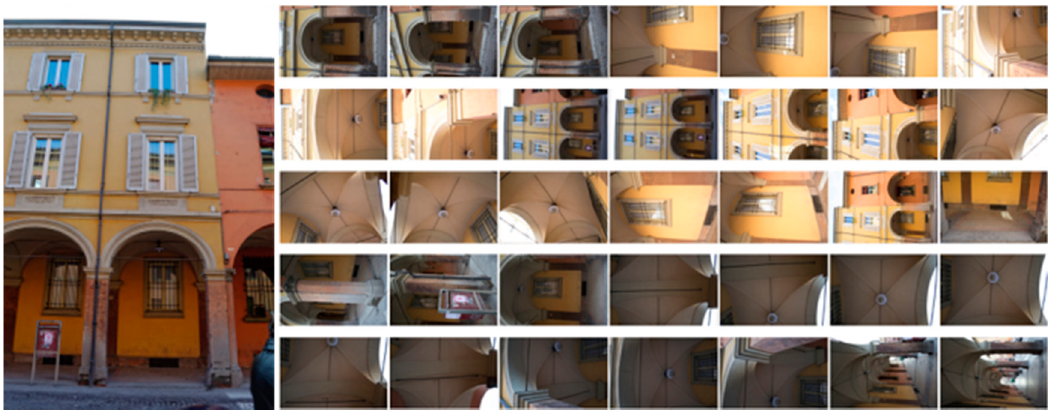
Figure 7. The building with portico dataset.